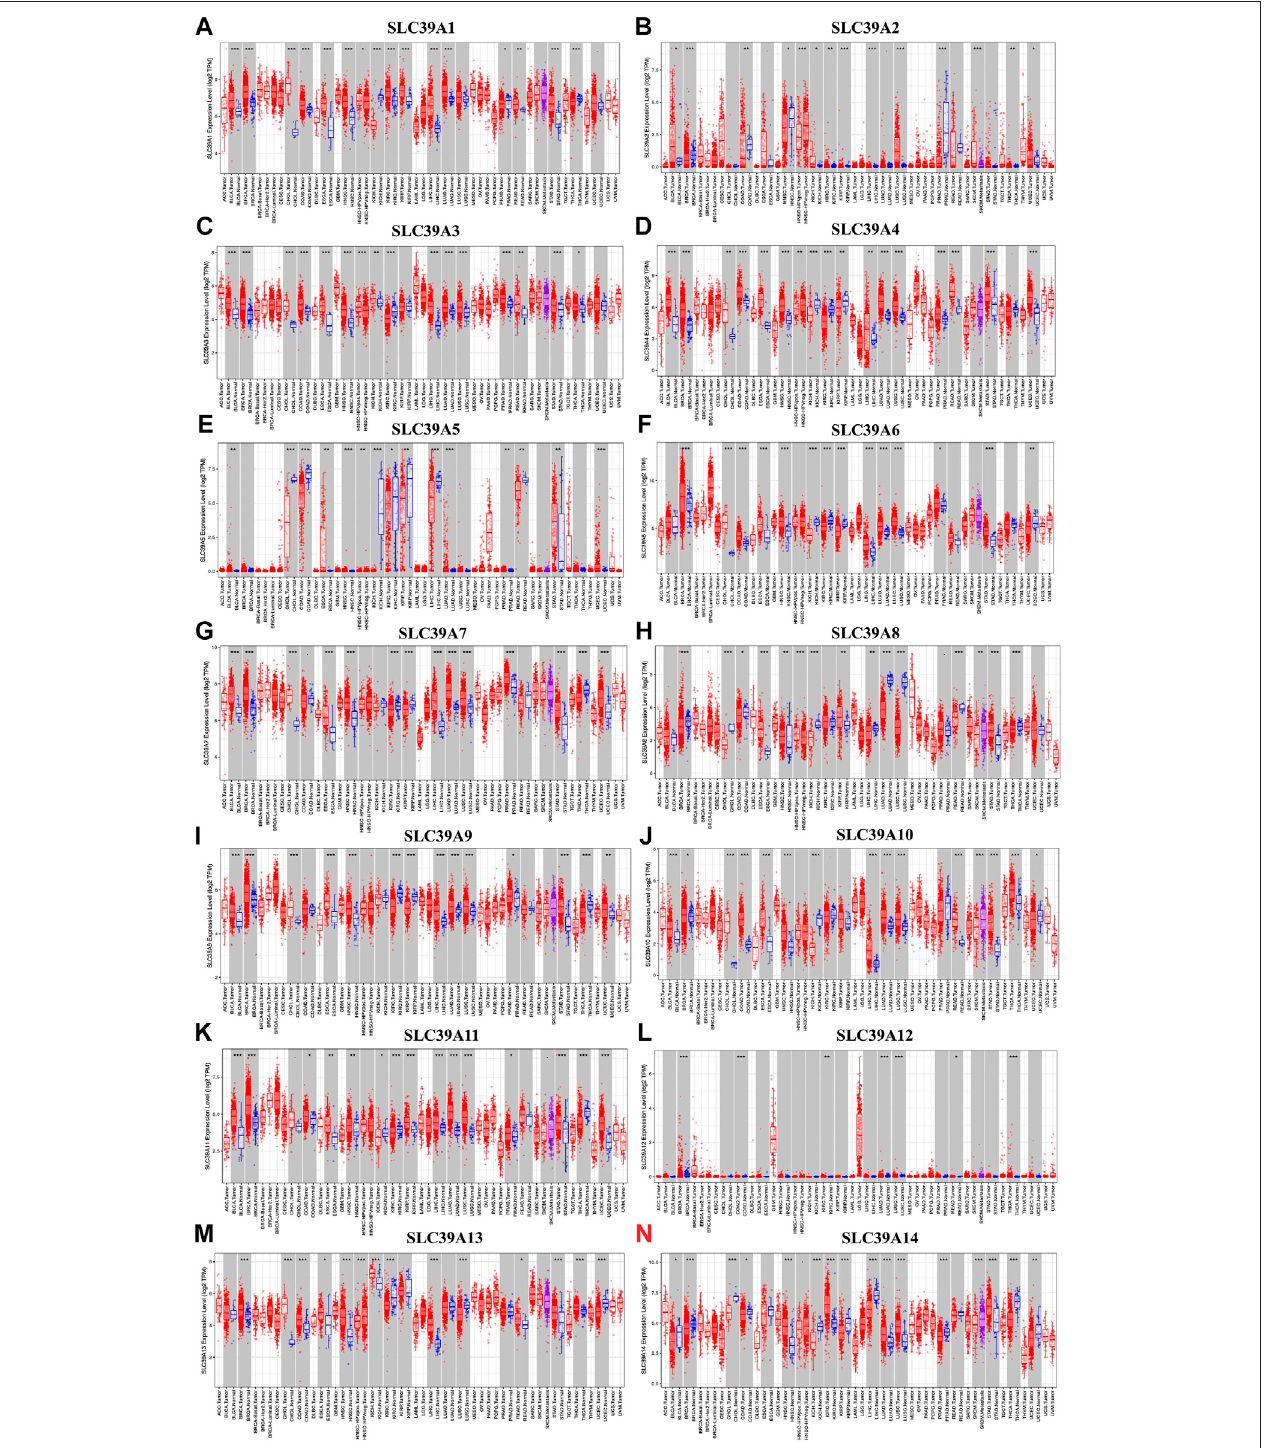
FIGURE 2 | Differential expression of the SLC39A family genes in pan-cancer and corresponding normal tissues. (A) Transcriptome expression of SLC39A1 was explored in the TIMER database. (B) Transcriptome expression of SLC39A2 was explored in the TIMER database. (C) Transcriptome expression of SLC39A3 was explored in the TIMER database. (D) Transcriptome expression of SLC39A4 was explored in the TIMER database. (E) Transcriptome expression of SLC39A5 was explored in theTIMER database. (F) Transcriptomeexpression of SLC39A6 was explored in theTIMER database. (G) Transcriptomeexpression of SLC39A7 was explored in the TIMER database. (H) Expression of SLC39A8 was explored in the TIMER database. (I) Transcriptome expression of SLC39A 9 was explored in the